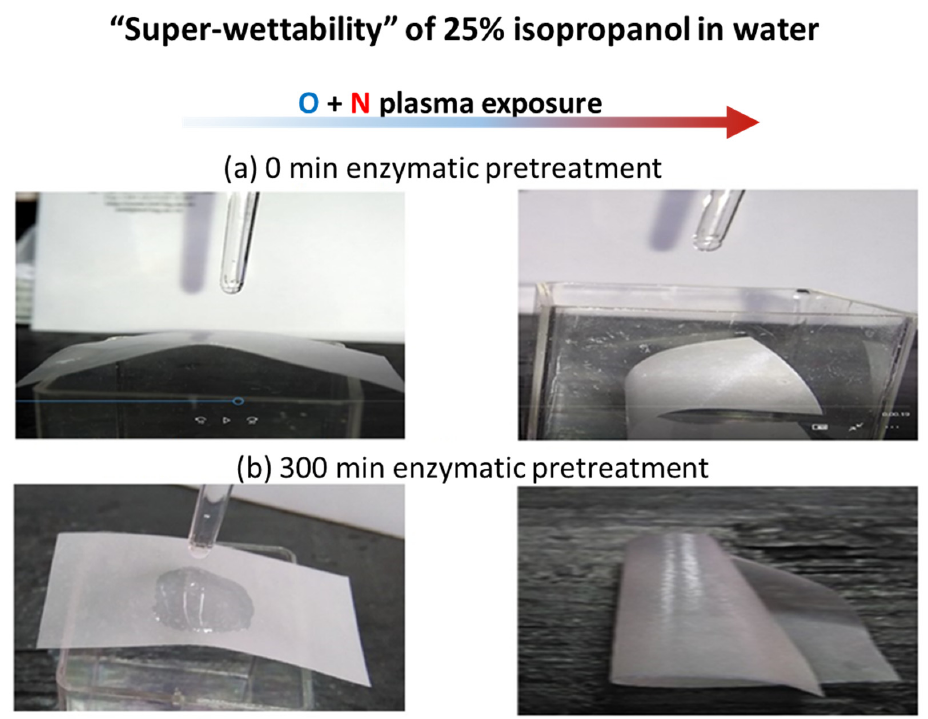
pretreatment: ( a ) without pretreatment, ( b ) 150 min, and ( c ) 300 min.